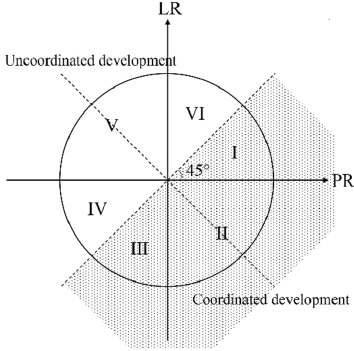
Figure 3. Schematic diagram of the partitioning criterion of different coordination relationship types. Table 2. Types of coupling relationship between urban population and land.